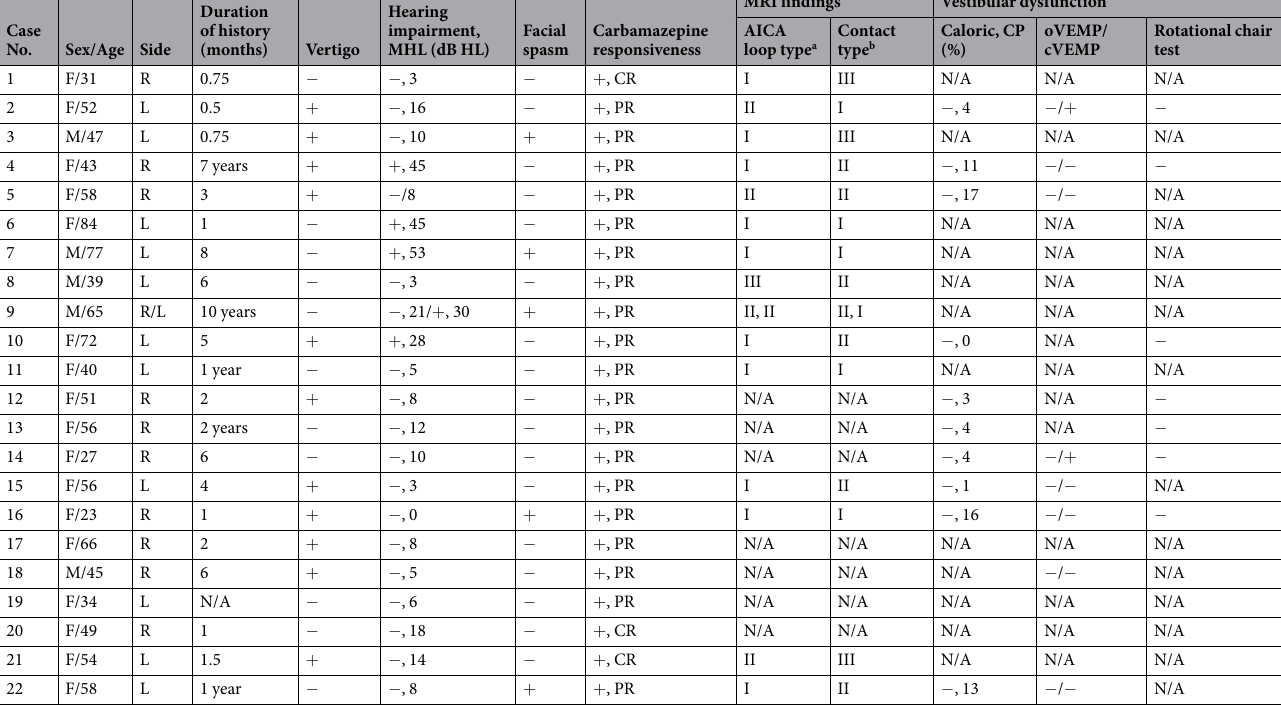
Table 1. Raw Data for 22 Cases of Typewriter Tinnitus. MHL, mean hearing level, the average hearing threshold at 0.5, 1, 2, and 3 kHz; AICA, anterior-inferior cerebellar artery; CP, canal paresis; CR,